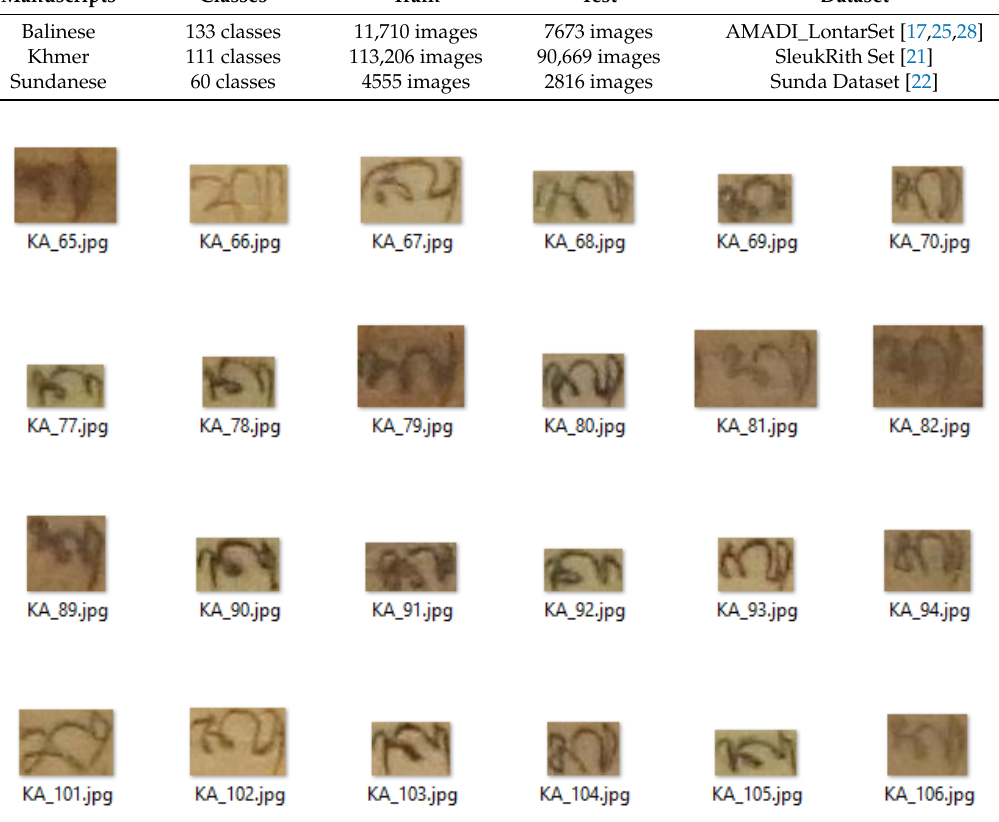
Figure 14. Balinese character dataset.